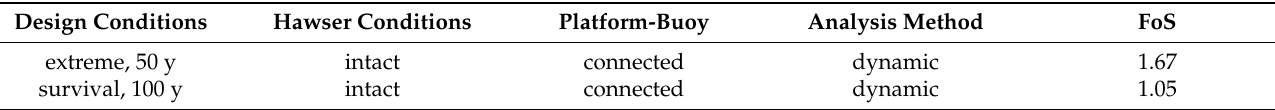
Table 3. Mooring hawser safety factors (WEC platform connected).